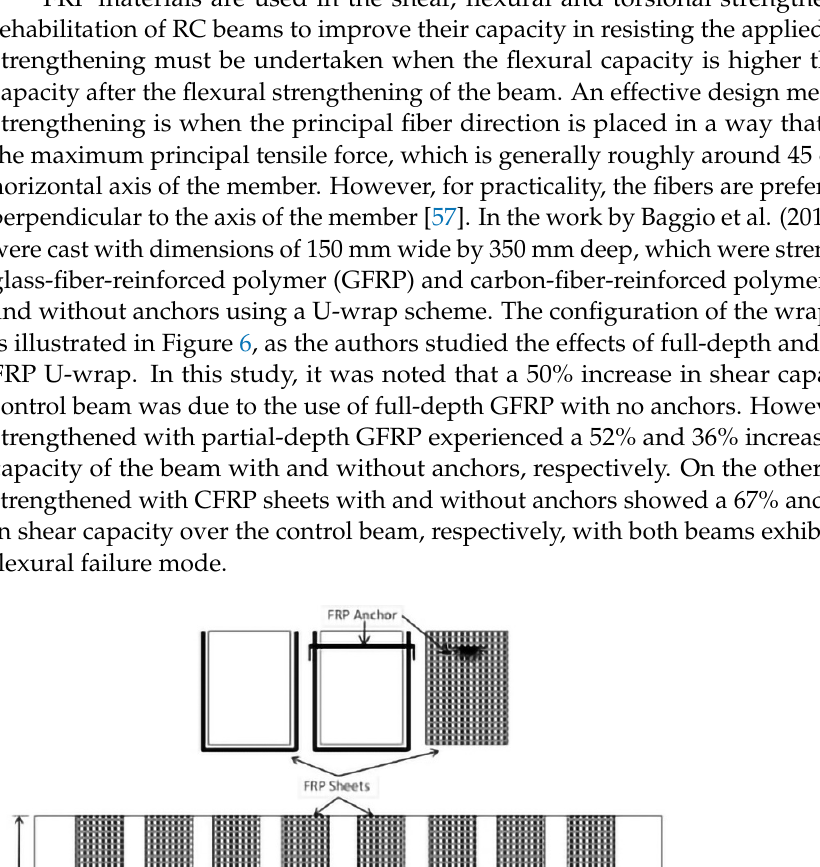
Figure 6. Shear strengthening using a U-wrap scheme [58]. The shear strengthening using CFRP with a U-wrap scheme was investigated [59]. The spacing between the fibers was the parameter to be changed. The dimensions of the casted beams were 120 mm wide by 300 mm in depth, with a length of 2000 mm. Epoxy Sikadur-41 and Sikadur-31 CF were used. The configuration of the wrapping scheme is shown in Figure 7. The failure modes experienced are summarized in Figure 8. It is noted that the U-wraps were only activated by 22%, where the fiber experienced debonding fail- ure from the concrete beam.